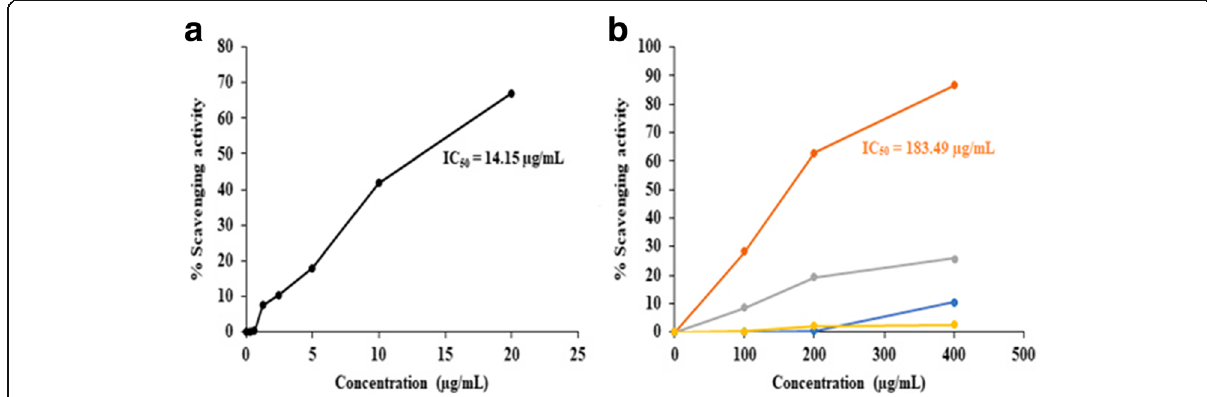
Fig. 1 a DPPH radical scavenging activity of quercetin. b Comparison of DPPH radical scavenging activity of methanolic extracts of Nyctanthes arbor-tristis leaves (orange), unripe fruit pulp of Aegle marmelos (grey), terminal meristem of Musa paradisiaca flower (blue) and ripe fruit pulp of Aegle marmelos (yellow)